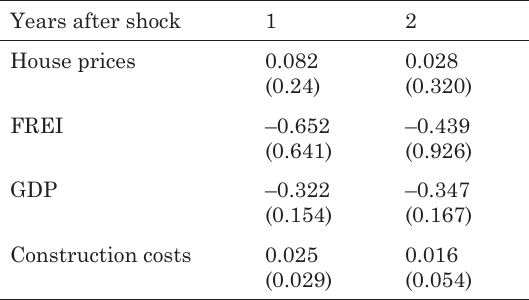
Table 3. responses to an interest rate shock